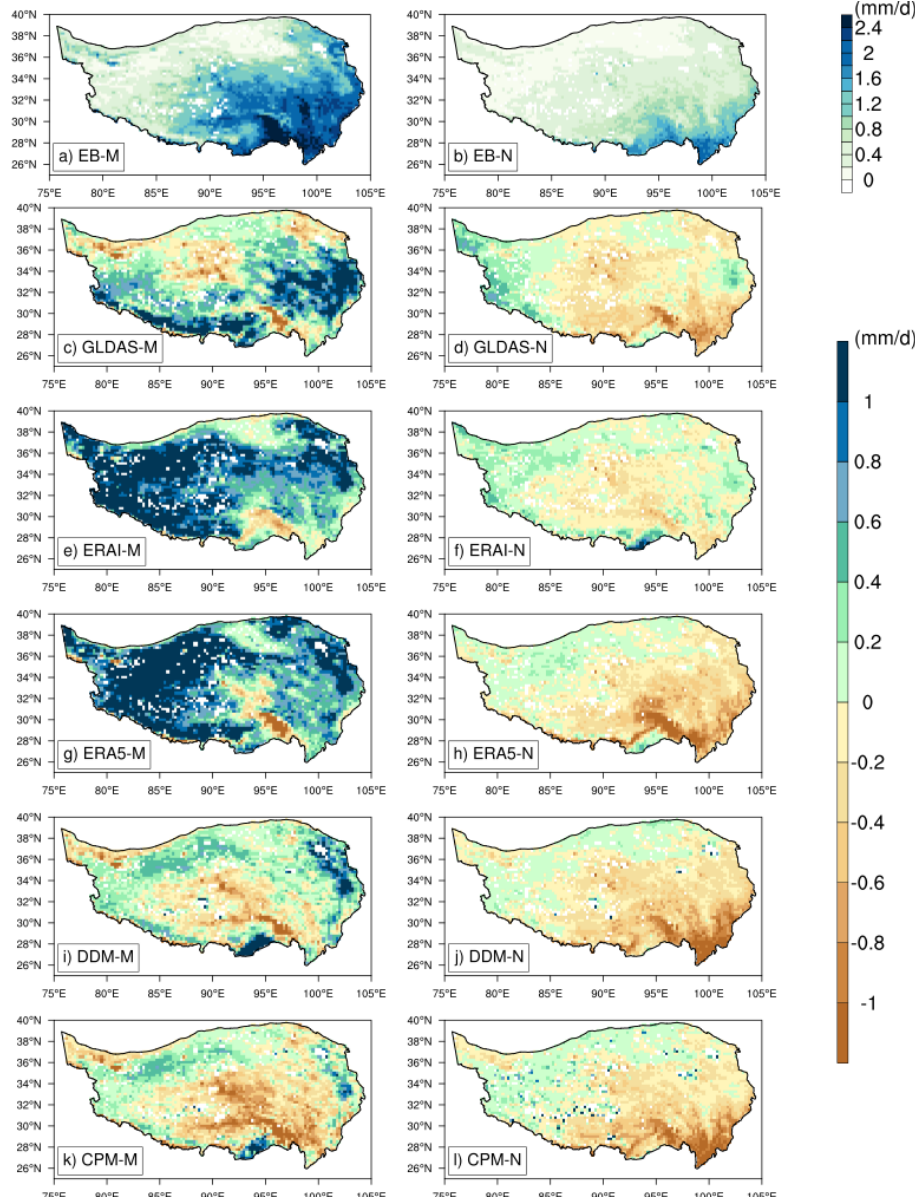
Figure 4. Distributions of the daily ET from the ( a , b ) EB data (units: mm/d), and ( c – l ) the differences of the ( c , d ) GLDAS, ( e , f ) ERA-Interim, ( g , h ) ERA5, ( i , j ) DDM, and ( k , l ) CPM data compared to EB, averaged over the monsoon (left-hand panels) and non-monsoon (right-hand panels) sea- sons.